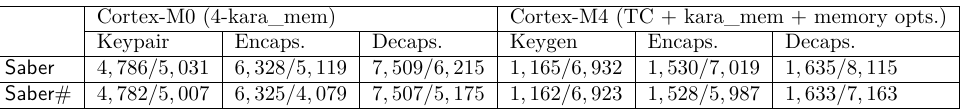
Table 2: Speed/memory requirements for Saber and Saber# . cycles × 10 3 /memory